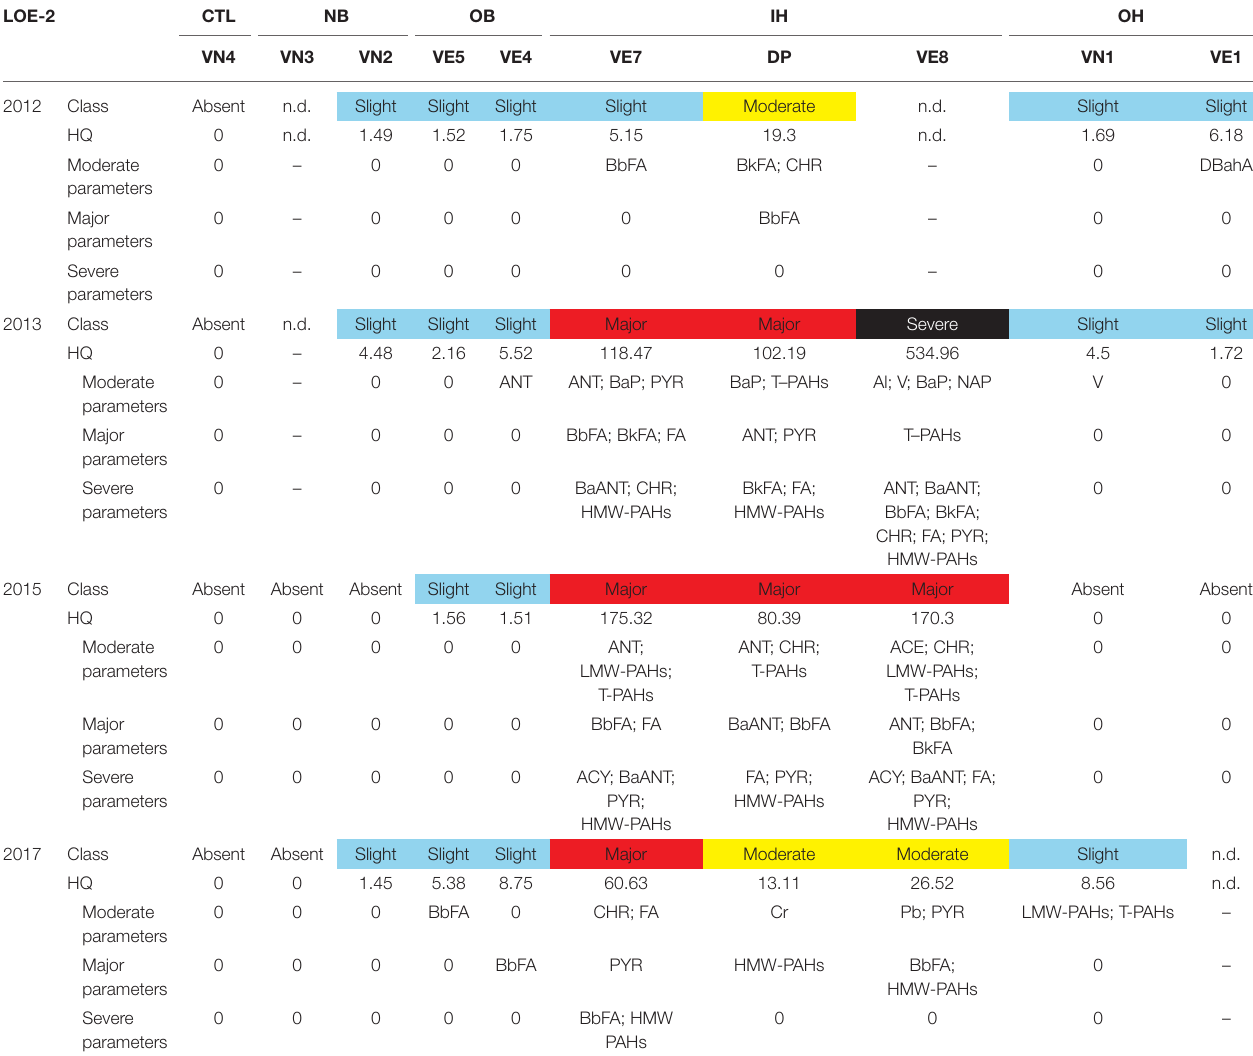
TABLE 2 | Results of the weighted elaboration of chemicals bioavailability, LOE-2.